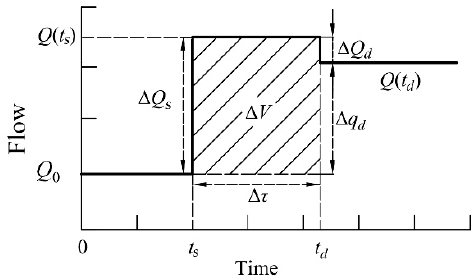
Figure 2. Schematic diagram of volume compensation algorithm with two adjustments.